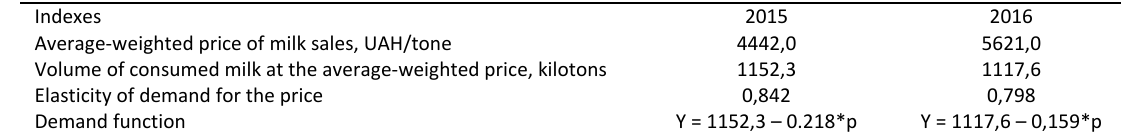
Table 4: Components of calculation of the function of demand for milk in 2015-2016